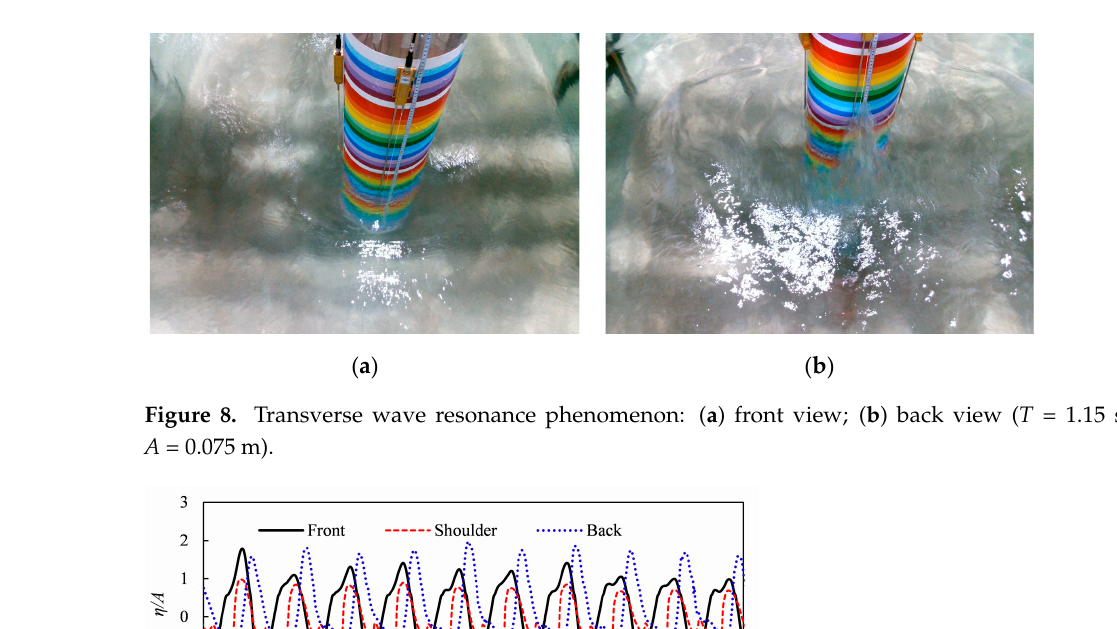
Figure 7. The run-up on monopile for different wave steepness: ( a ) run-up at the front point, ( b ) run-up at the shoulder point, and ( c ) run-up at the back point.